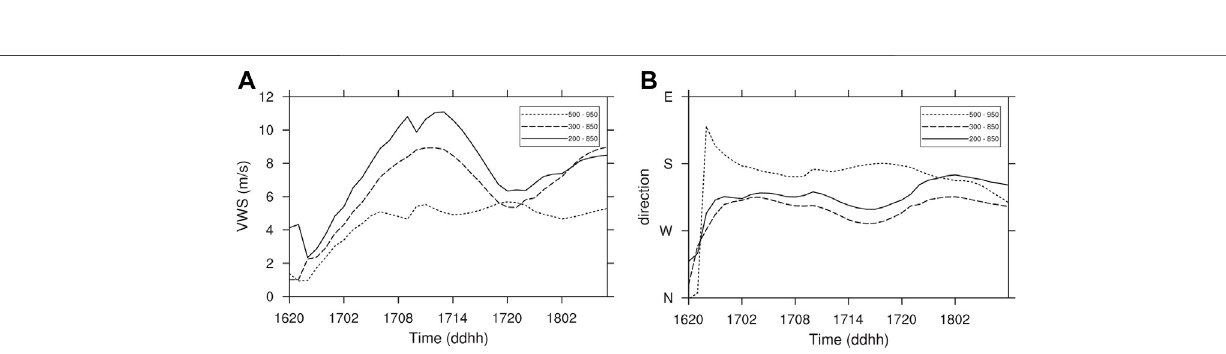
Frontiers in Earth Science |